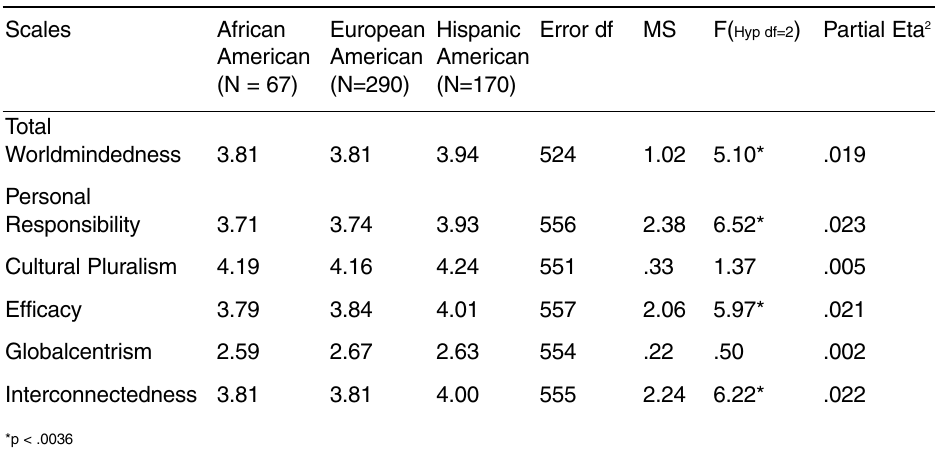
Ethnicity Means